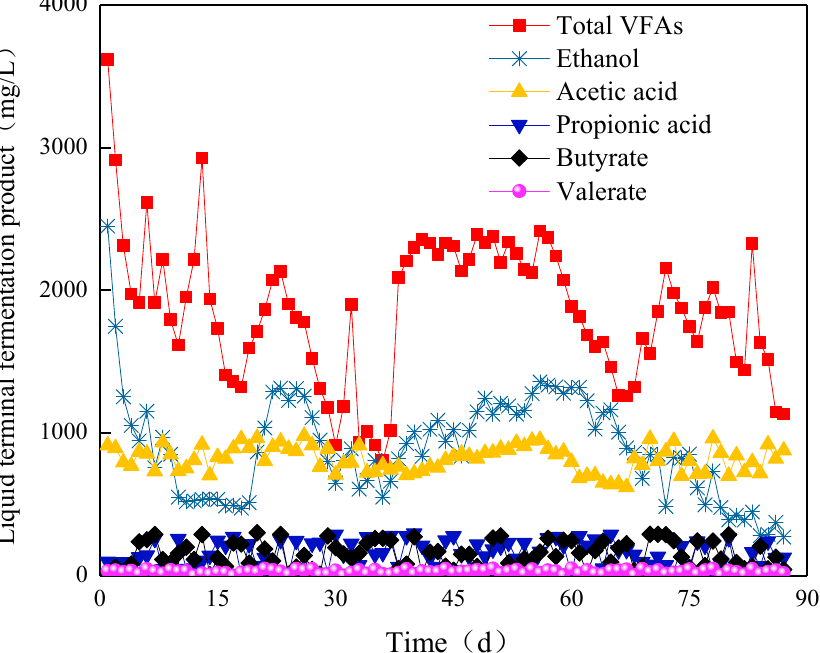
Figure 8. Ethanol and volatile fatty acids (VFAs) yields in Compartment I.